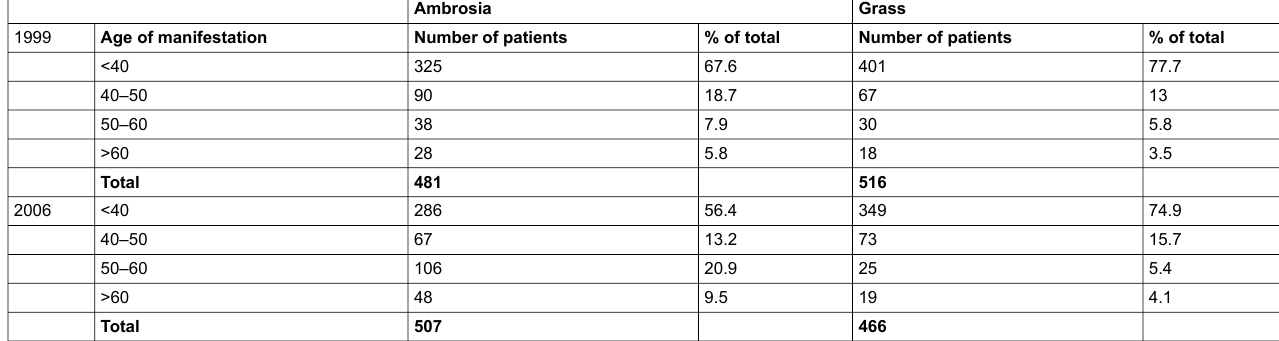
Table 2: Sensitisation to Ambrosia and grass pollen (SPT positive) in Legnano in the years 1999 and 2006 stratified into age groups. Ambrosia Grass 1999 Age of manifestation Number of